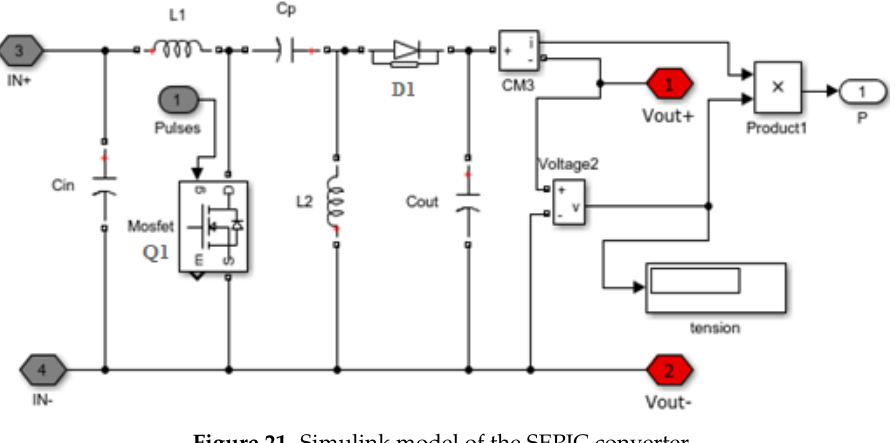
Figure 21. Simulink model of the SEPIC converter.